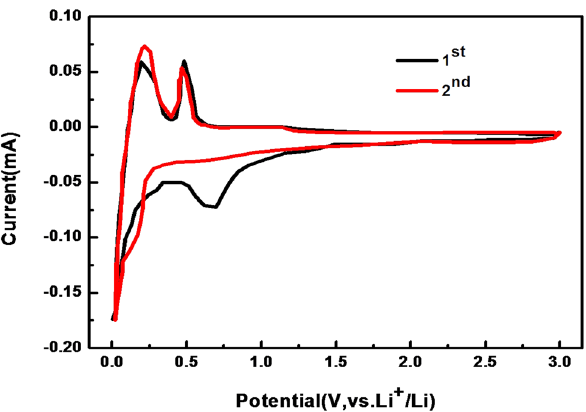
Figure 6: CVs of C@Al – EG composites containing 30% Al nanoparticles.